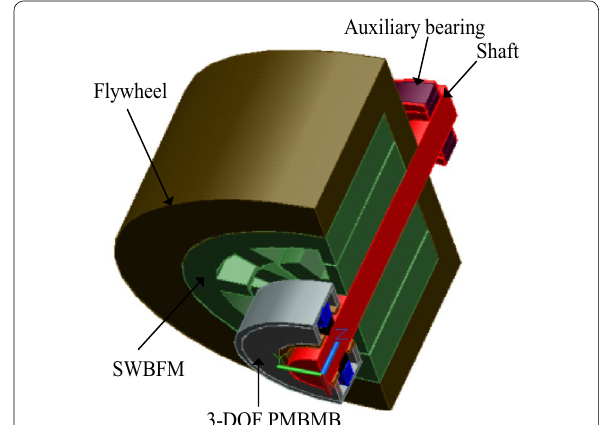
Figure 1 Structure of the flywheel